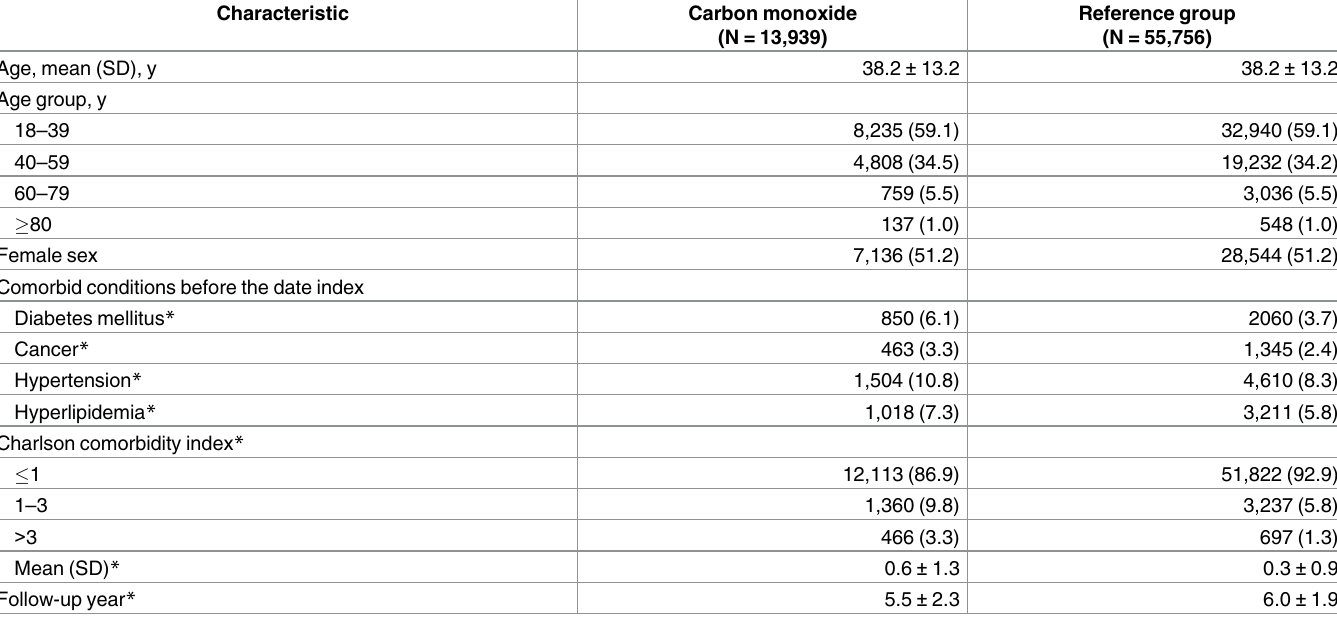
Table 1. Demographic and clinical characteristics of the study population